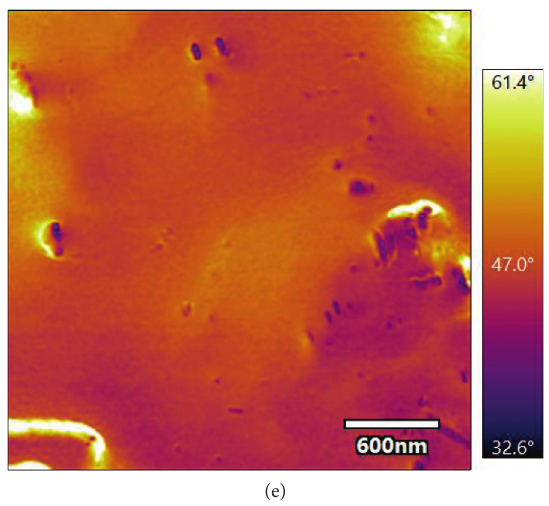
Figure 5: Phase diagram of (a) C-10, (b) C-15, (c) C-20, (d) C-25, and (e)